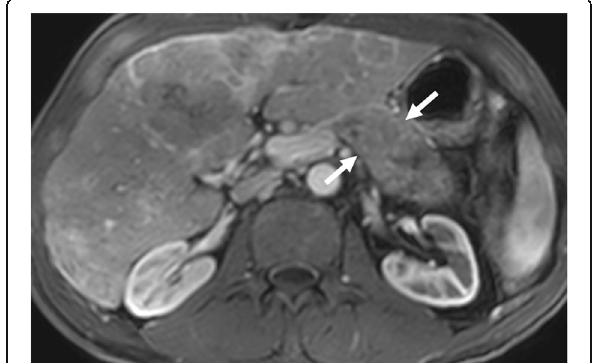
Fig. 6 A 60-year-old male with known metastatic gastric NET. Axial plane portal phase postcontrast T1W MR image shows extensive tumor thrombus within the splenoportomesenteric venous junction extending into the splenic vein (arrows). Note that the endovenous tumor infiltrates beyond the confines of the splenic vein